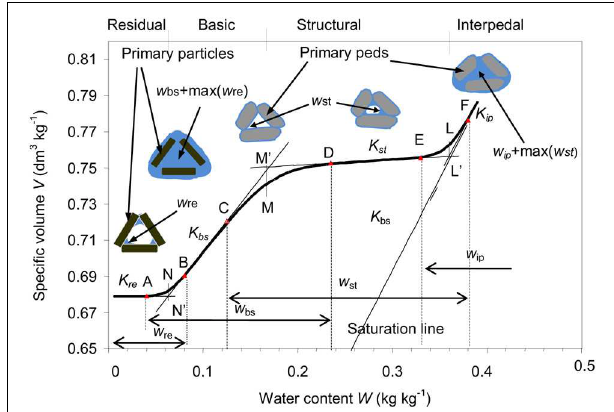
FIGURE 3 | Various configurations of air and water partitioning into the two pore systems, inter and intra primary peds, related to the shrinkage phases of a standard Shrinkage Curve [water content vs. specific volume]. The various water pools [wre, wbs, wst, and wip] are represented with their domain of variations. The linear and curvilinear shrinkage phases are delimited by the transition points (A–F). Points N’, M’, and L’ are the intersection points of the tangents at those linear phases of the Shrinkage Curve. Adapted from Braudeau et al. (2004).